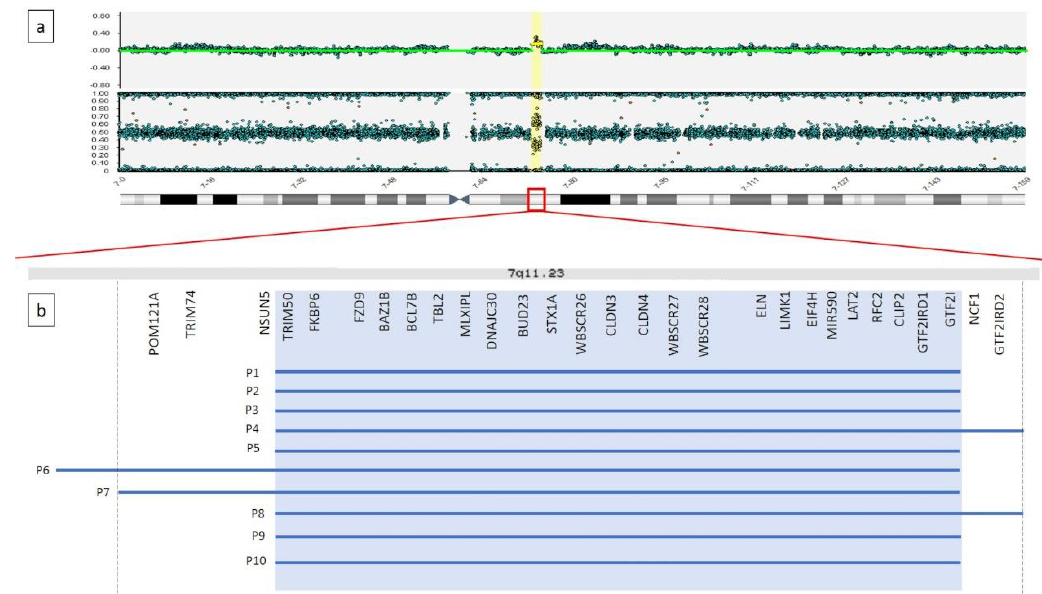
Table 1 and Figure 1. Brain Sci. 2020 , 10 , x FOR PEER REVIEW